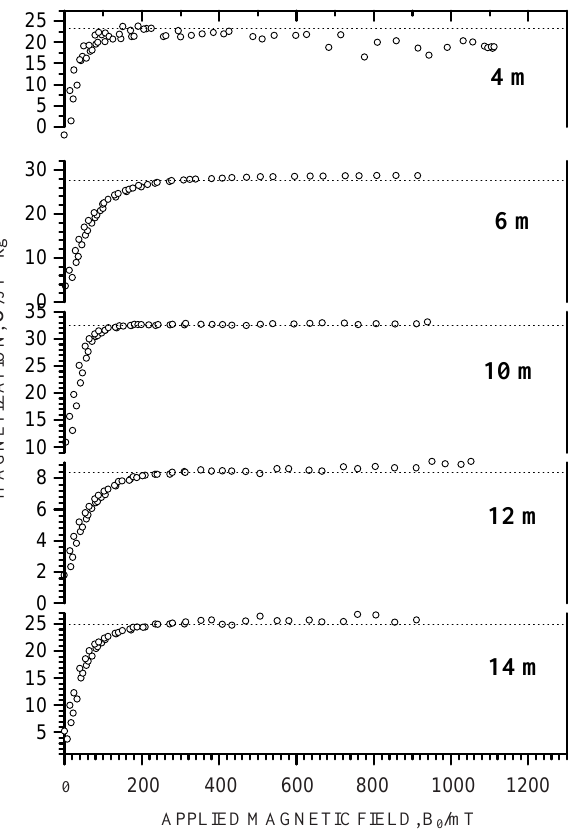
Figure 4. Magnetization measurement obtained from a selected single crystal of each sample group. Dotted straight lines represent linear reggressions comprising points of the plateau approaching